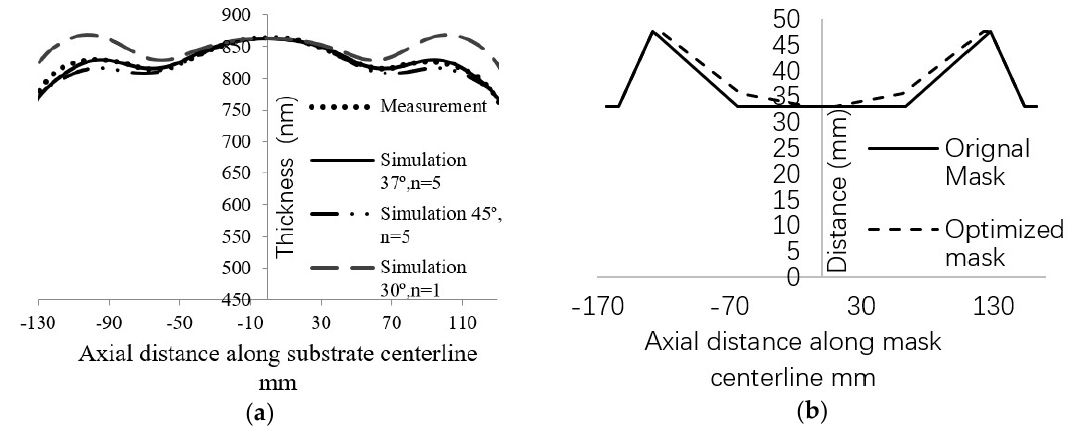
Figure 29. ( a ) Simulated uniformity distribution and measured uniformity distribution, n and φ 0 are obtained by fitting measured data with the original mask shape, the mask shape was then optimized using these parameters; ( b ) Original mask shape and optimized mask shape. using these parameters; ( b ) Original mask shape and optimized mask shape.